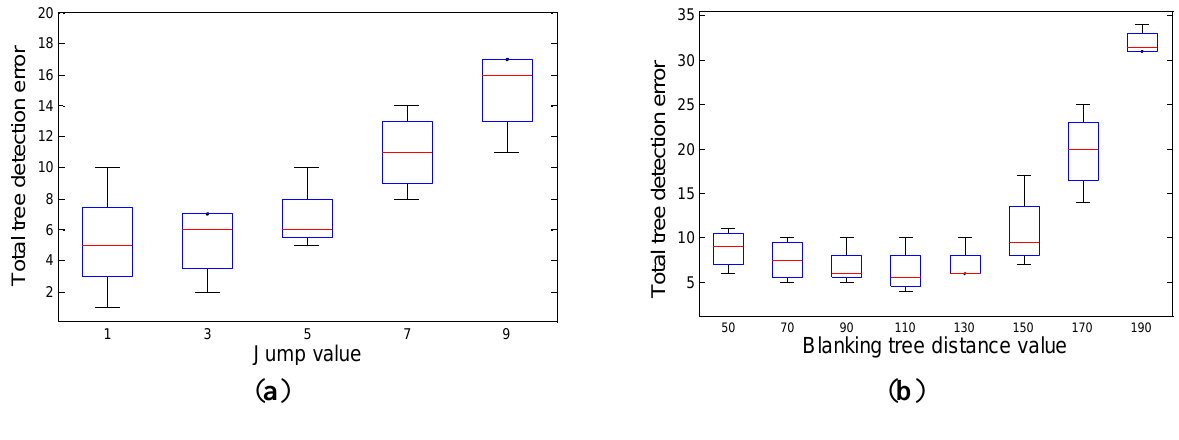
LIDAR sensor using different parameter values: ( a ) Jump parameter with a Fischer value of 5.79. ( b ) Blanking tree distance parameter with a Fisher value of 24.44. On each box, the central mark is the median, the edges of the box are the 25th and 75th percentiles, and the whiskers extend to the most extreme data